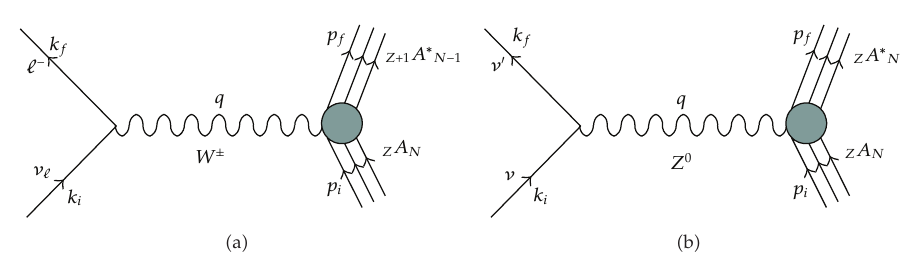
Figure 1: Feynman-diagram of lowest order for: (cid:3) a (cid:4) the CC neutrino-nucleus reactions ν l (cid:5) (cid:3) A,Z (cid:4) → l − (cid:5) (cid:3) A,Z (cid:5) 1 (cid:4) ∗ , and (cid:3) b (cid:4) the NC neutrino-nucleus processes ν (cid:5) (cid:3) A,Z (cid:4) → ν (cid:4) (cid:5) (cid:3) A,Z (cid:4) ∗ . The diagrams which correspond to the antineutrino reactions are